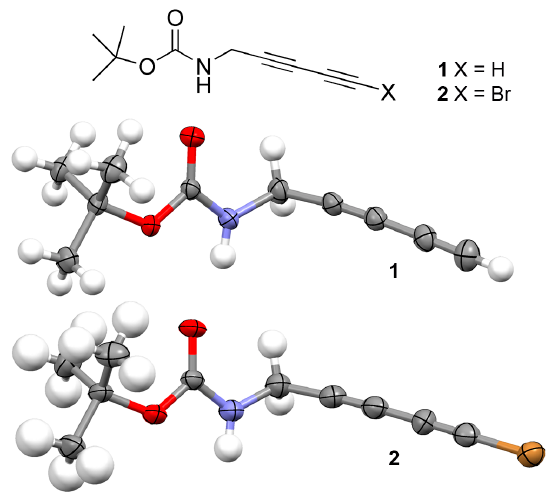
Figure 1. Chemical and crystal (ORTEP) structures of the diacetylene derivatives 1 (BocNHCH 2 CCCCH) and 2 (BocNHCH 2 CCCCBr).